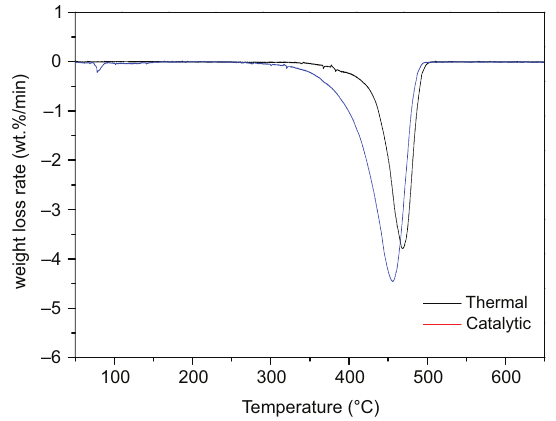
Figure 2. DTG plot of plastic sample in thermal and catalytic